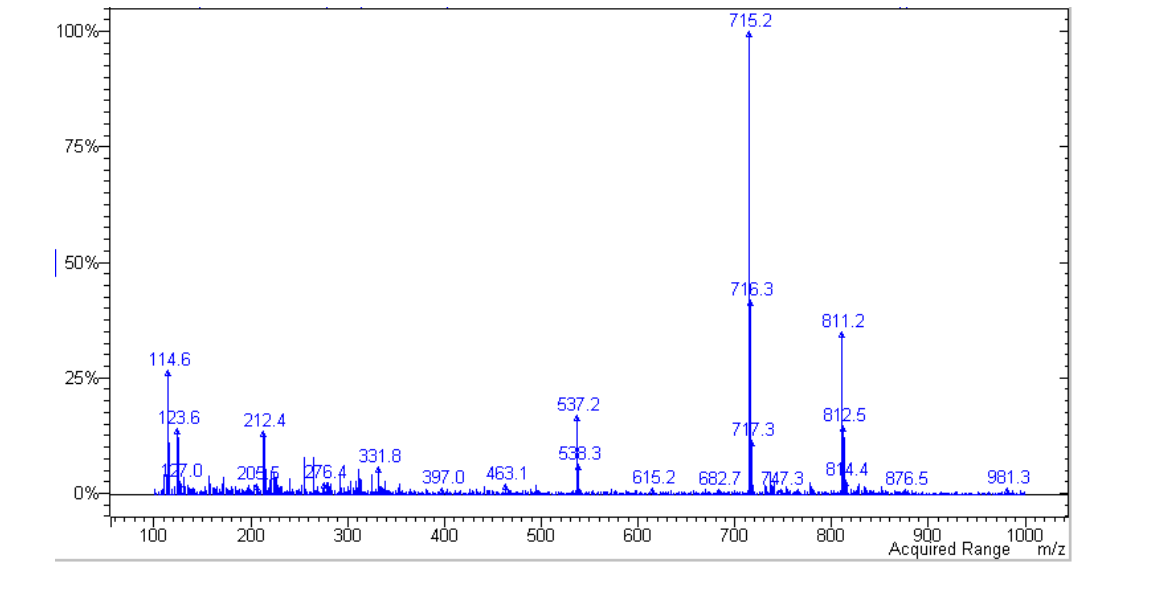
Figure 2. Full (-)ESI-MS spectrum of bis- NBD-DB18-C-6. Table 1. Changes in chemical shifts upon complexation of bis -NBD-DB18-C-6 with K + and Na + cations.